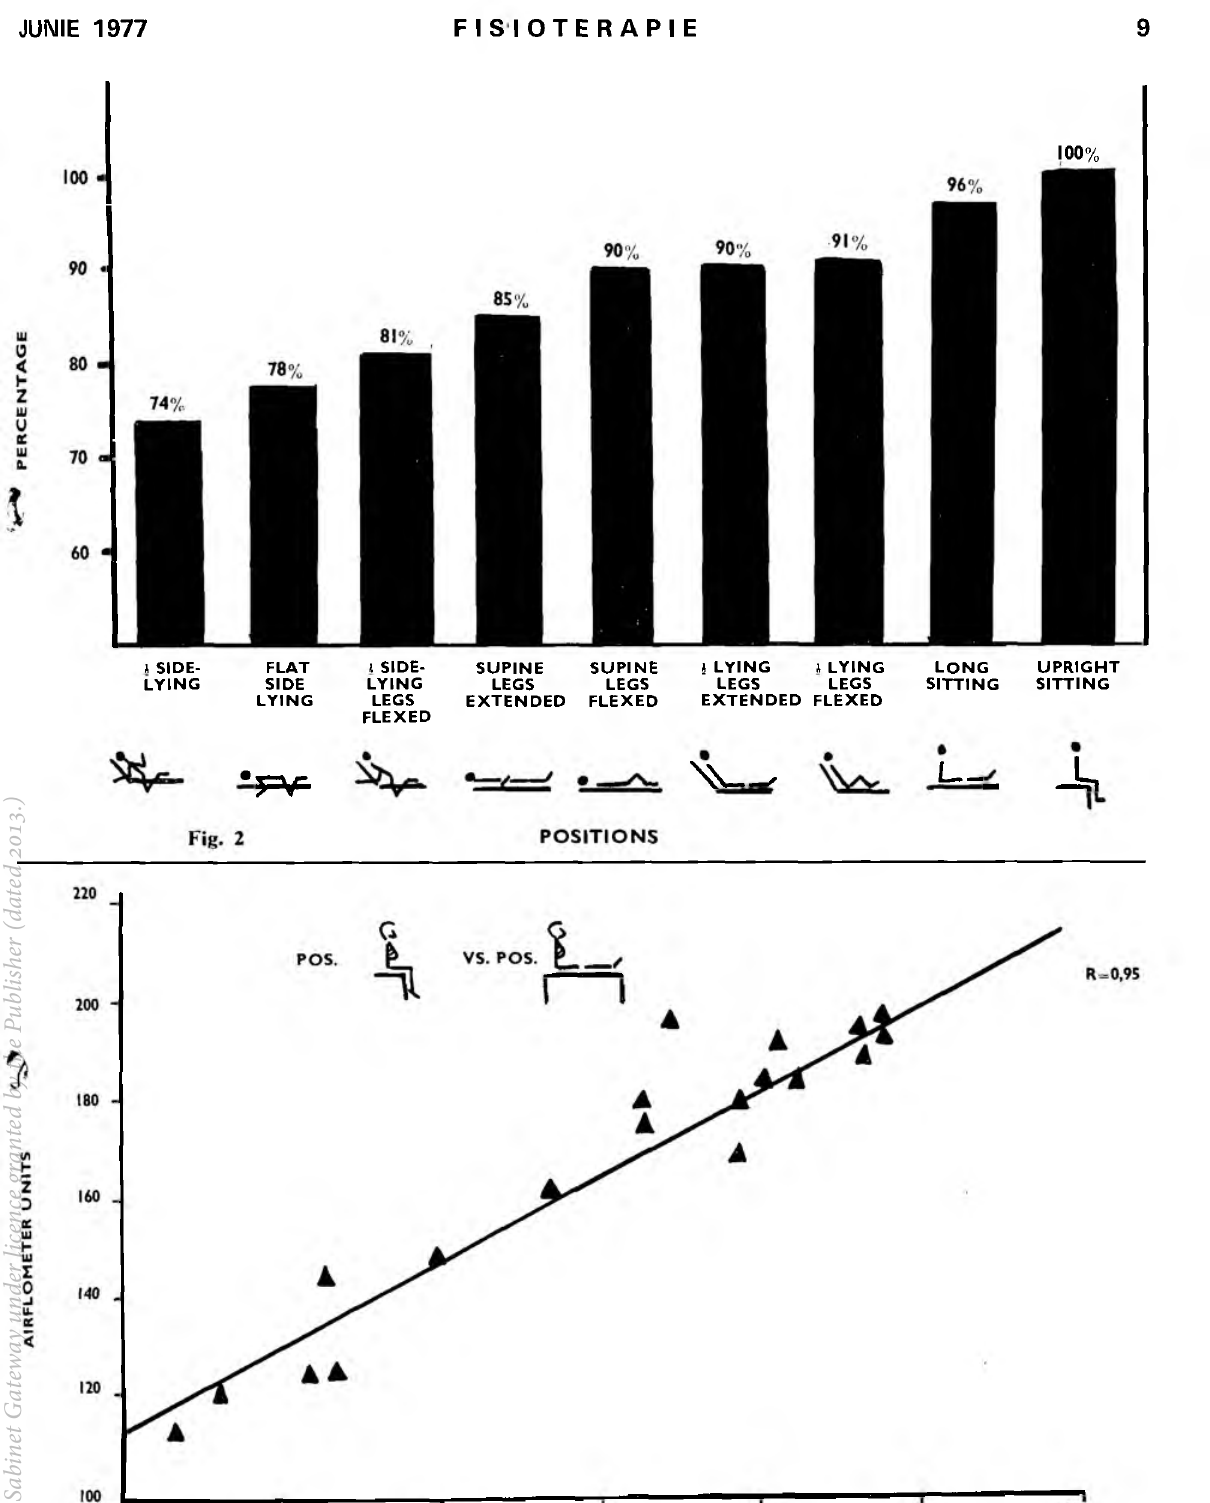
Fig. 3 AIRFLOMETER